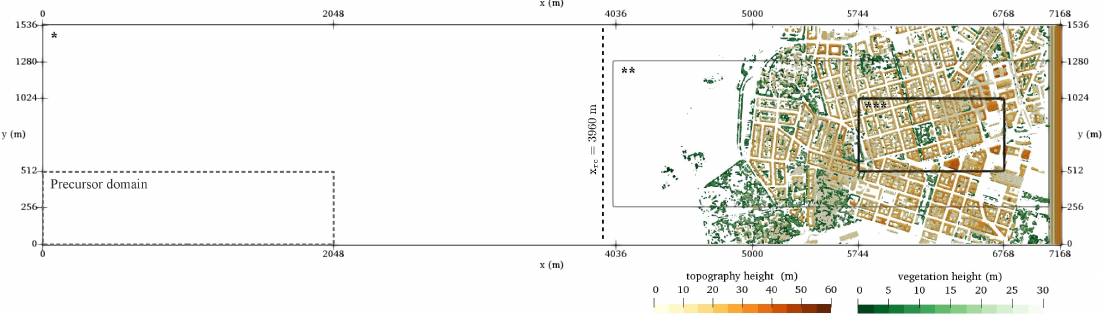
Figure 1. A two-dimensional visualization of the urban LES domain used in the study: The parent domain Ω ( 1 ) , domain Ω ( 2 ) , and Ω ( 3 ) are marked with *, **, and ***, respectively, in the upper left corner of the domains’ highlighted borders. The urban turbulence data is primarily extracted from within the Ω ( 3 ) domain, which is discretized with uniform 1 m resolution ( ∆ = H /20). The horizontal extent of the precursor simulation domain, used to initialize the urban LES, is also shown in the bottom left corner of the parent